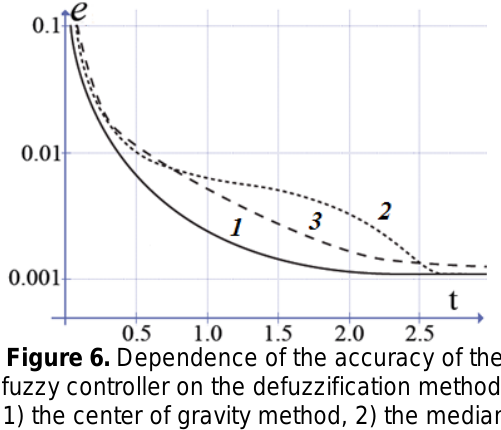
Figure 6. Dependence of the accuracy of the fuzzy controller on the defuzzification method: 1) the center of gravity method, 2) the median method, 3) the maximum method